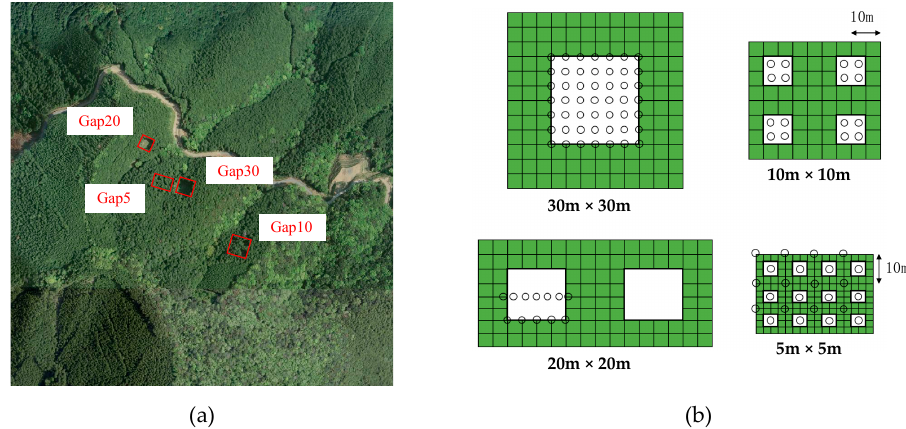
Figure 1. ( a ) Aerial photography of study site; red squares denote gap-mosaic experiment plots. Cypress plantation is adjacent to an evergreen broad-leaved forest, shown in lower right. ( b ) Four types of gap arrangements: green and white, plantation areas and canopy gaps, respectively; open circles, seed traps.